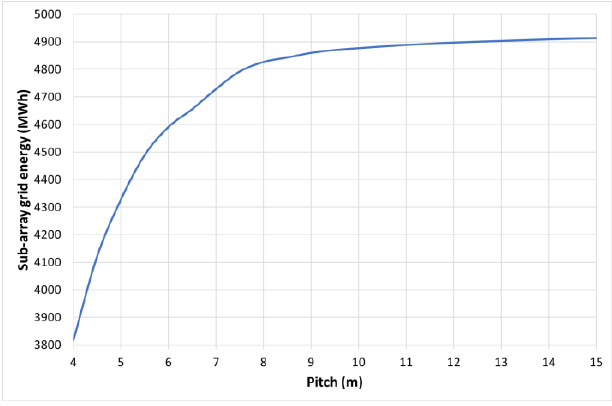
Figure 6. Sub-array grid injected energy as a function of pitch; 30º tilt angle; landscape; central inverter.